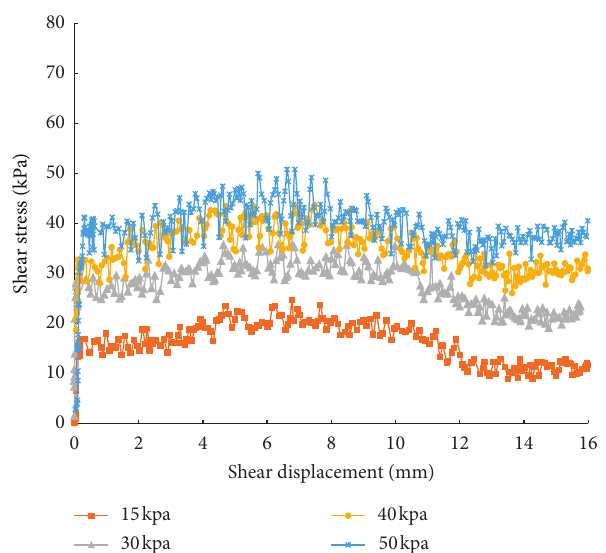
Figure 14: Shear stress-shear displacement curve of 0.8cm vertical kraft paper-reinforced